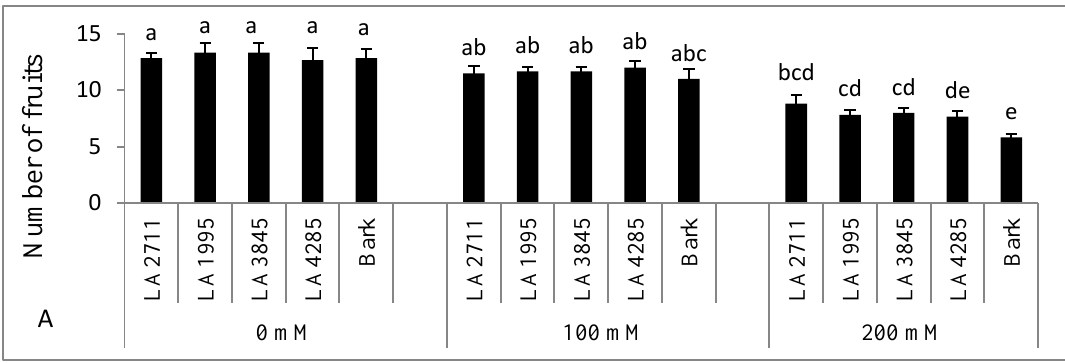
Figure 3: Effect of salt treatments and rootstocks on ( A ) root length, ( B ) root fresh weight, and ( C ) root dry weight. Different letters indicate significant differences between treatments (Tukey test at p < 0.05). Table 7. Analysis of variance (mean square) of tomato root attributes.